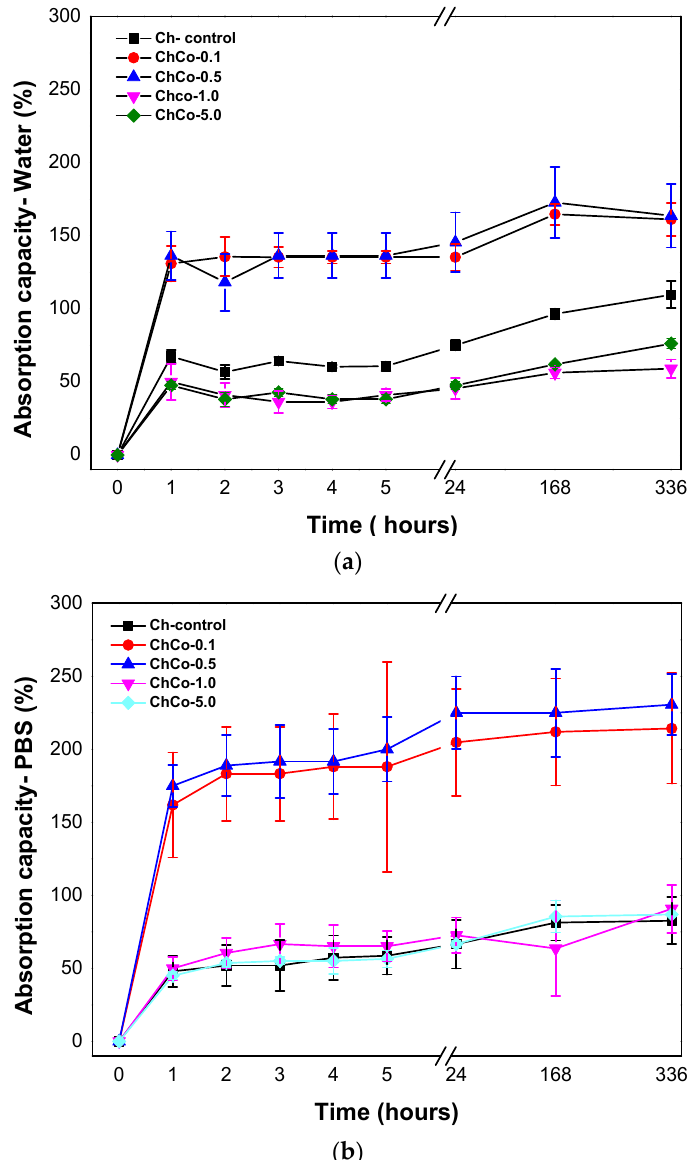
Figure 3. ( a ) Degree of absorption of membranes in aqueous medium as a function of time; ( b ) Degree of absorption of membranes in phosphate-saline buffer solution (PBS) as a function of time.